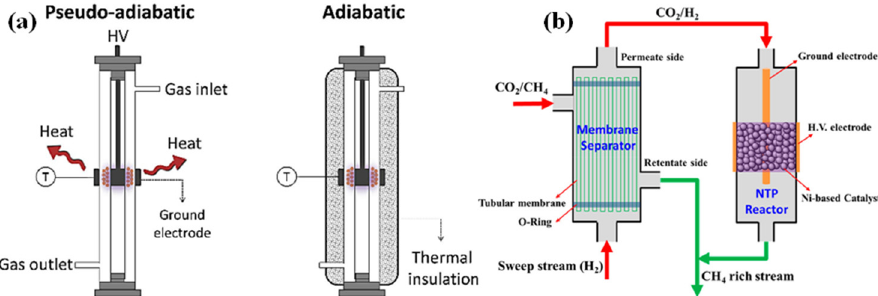
Figure 8. Various reactor designs: ( a ) Reactor configuration: ( left ) pseudo-adiabatic and ( right ) adiabatic. Reprinted with permission from [133]. Copyright 2020 Elsevier. ( b ) DBD reactor integrated with membrane separator. Reprinted with permission from [134]. Copyright 2020 American Chemical